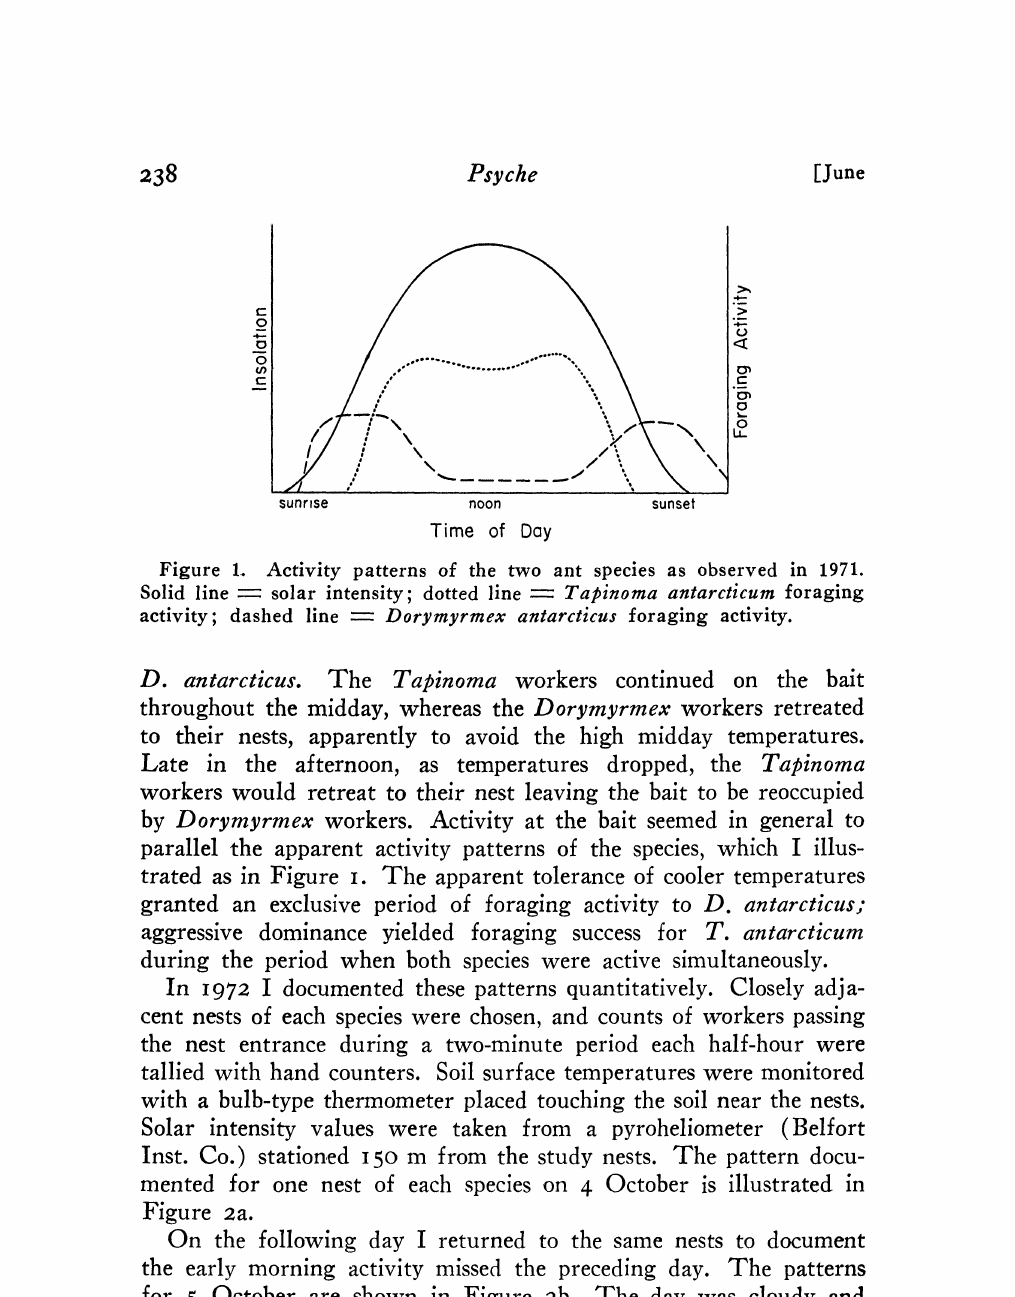
Figure L Activity patterns of the two ant species as observed in 1971. Solid line solar intensity; dotted line Tapinoma antarcticum foraging activity; dashed line Dorymyrmex antarcticus t?oraging